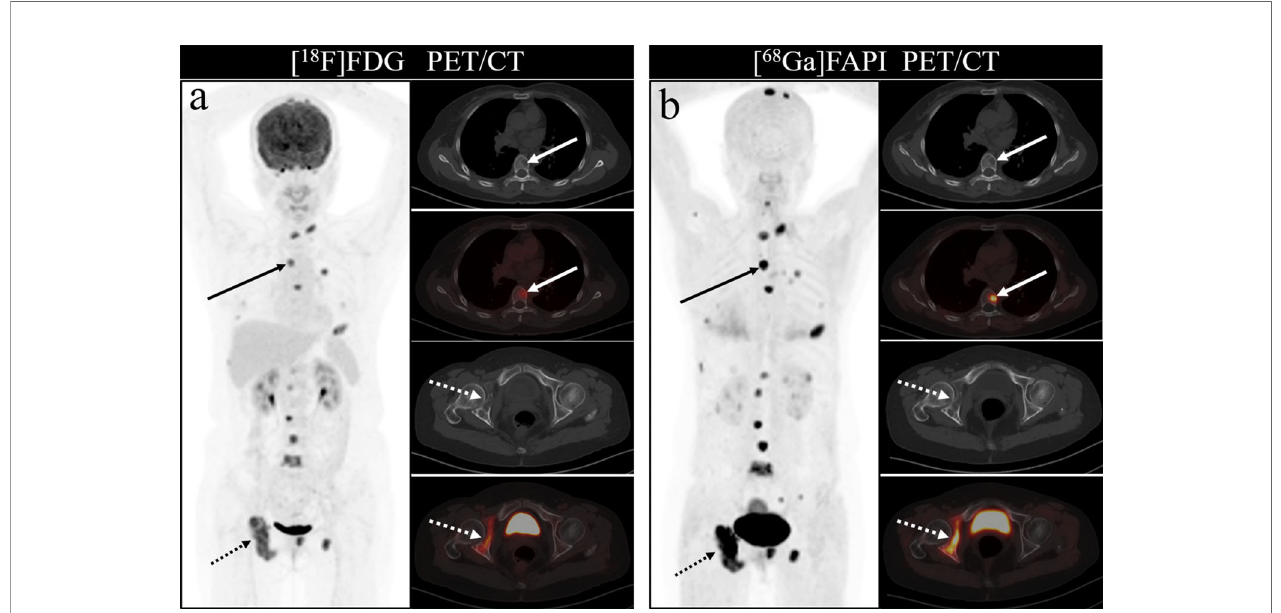
FIGURE 3 | A 46-year-old woman with a newly diagnosed lung cancer underwent [ 18 F]FDG and [ 68 Ga]Ga-DOTA-FAPI-04 PET/CT (A, B) . The MIP images (A, B) of the [ 18 F]FDG and [ 68 Ga]Ga-DOTA-FAPI-04 PET/CT showed multiple bone lesions. On the selected axial images, [ 18 F]FDG PET/CT (A) only showed mild to moderate [ 18 F]FDG activities on thoracic vertebrae (arrows) and right acetabulum (dashed arrows), whereas [ 68 Ga]Ga-DOTA-FAPI-04 PET/CT (B) showed intense [ 68 Ga]Ga- DOTA-FAPI-04 uptakes in thoracic vertebrae (arrows) and right acetabulum (dashed